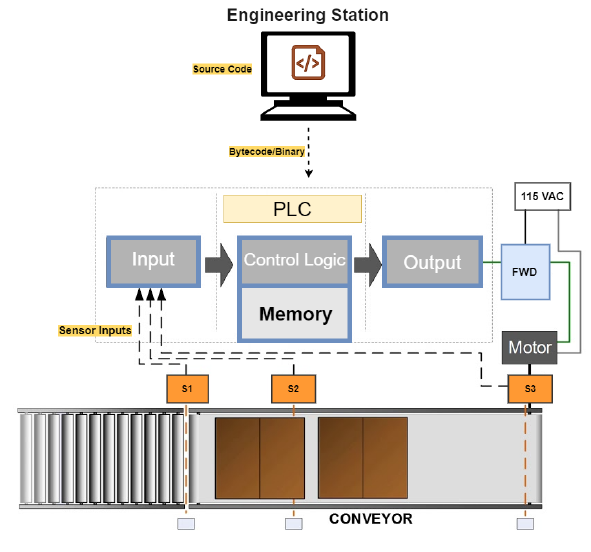
Figure 4. Example